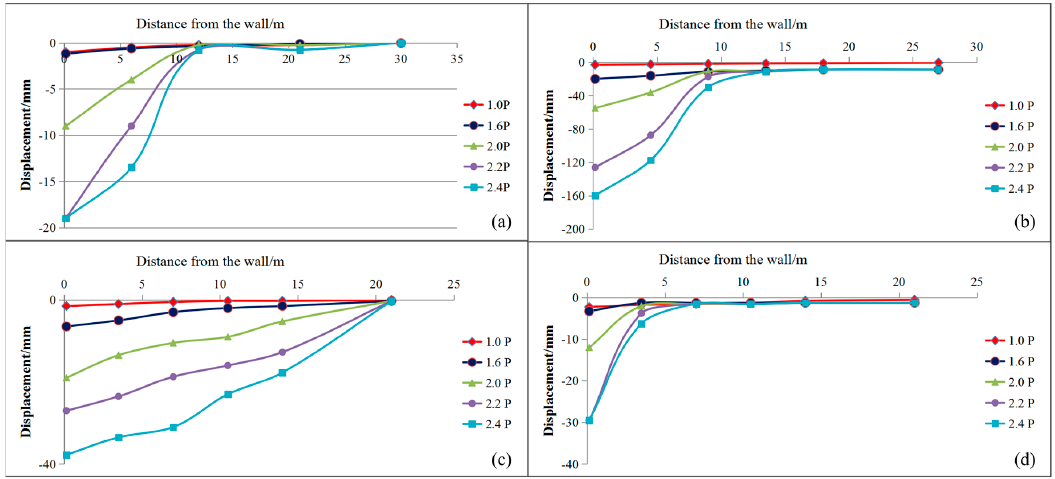
Figure 12. Displacement curve of different parts in terms of ( a ) parking lot waist; ( b ) parking lot vault; ( c ) main roadway waist; and ( d ) main roadway vault.